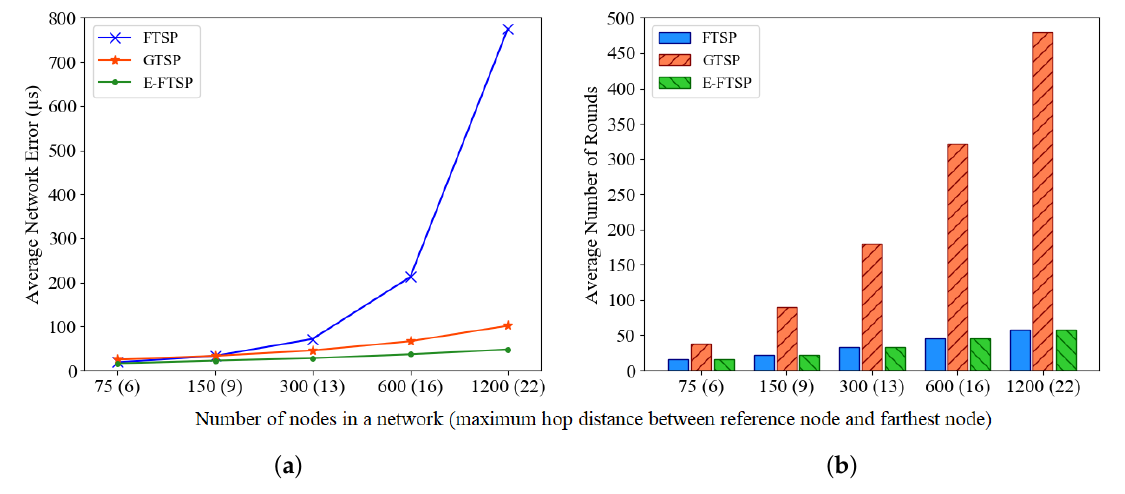
Figure 13. ( a ) Average network error of FTSP, GTSP, and E-FTSP according to the network size (number of nodes). ( b ) Average number of rounds required to synchronize entire network of FTSP, GTSP, and E-FTSP according to the network size (number of